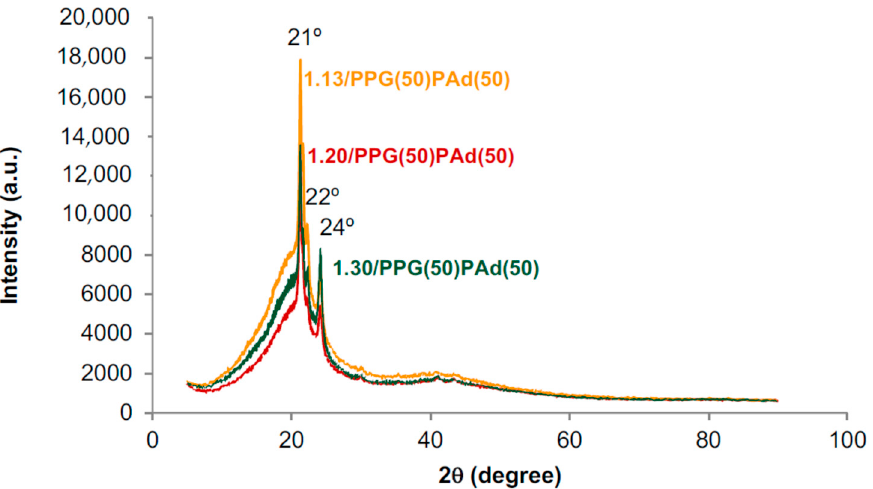
Figure 12. X-ray diffractograms of the TPUs synthesized with different NCO/OH ratios.